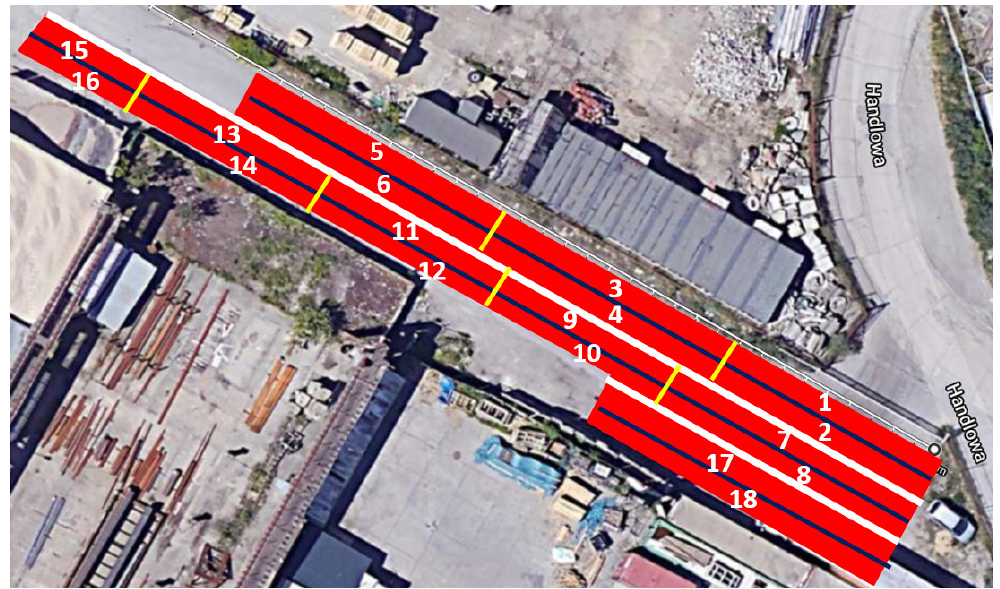
Figure 16. Layout of the test sections. Figure 16.